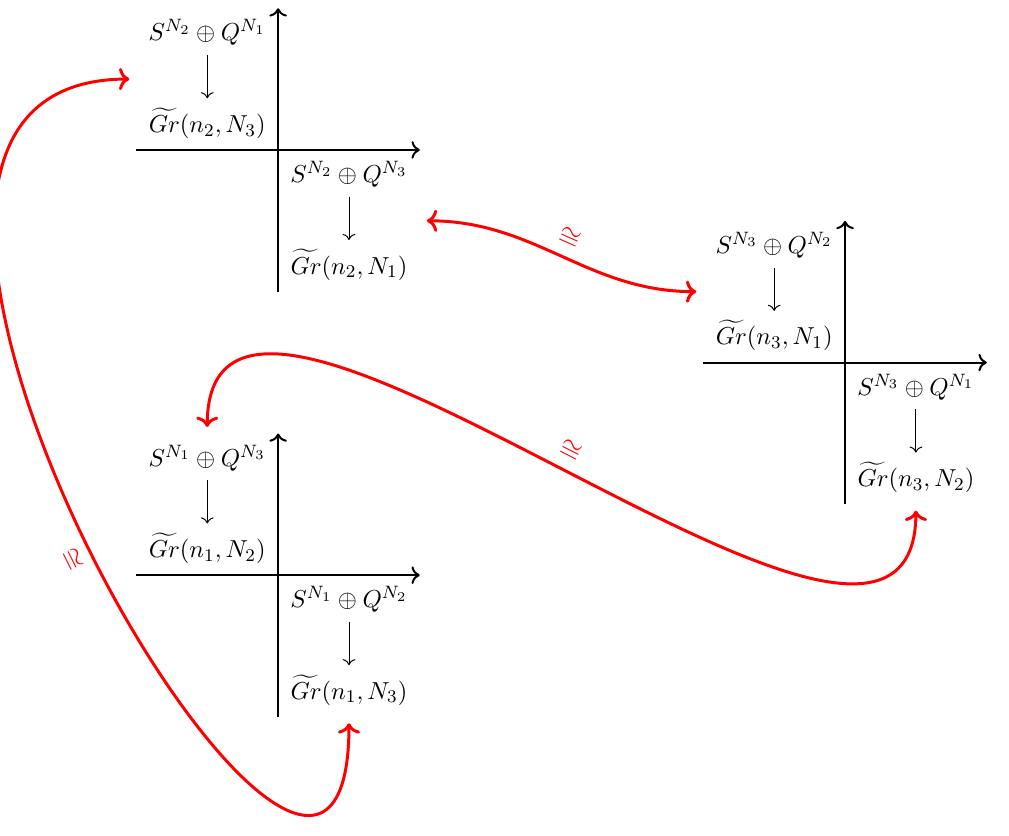
Figure 3 . Phase diagrams of the triple of GLSMs labelled by the permutations of ( N 1 ; N 2 ; N 3 ). The red arrows connect the regions where the theories are described by (0 ; 1) sigma-models with isomorphic targets and bundles of left-moving